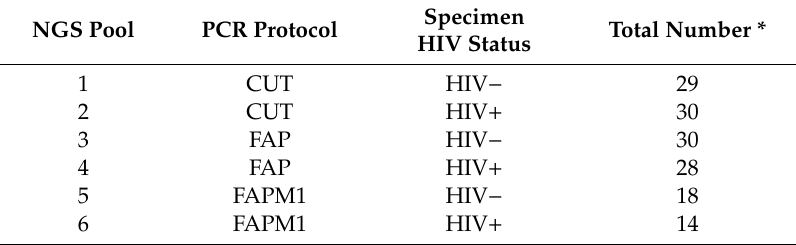
Table 1. Description of the next-generation sequencing (NGS) pools. Human Papillomavirus (HPV)-positive PCR products were grouped into six NGS pools according to HIV status and applied PCR